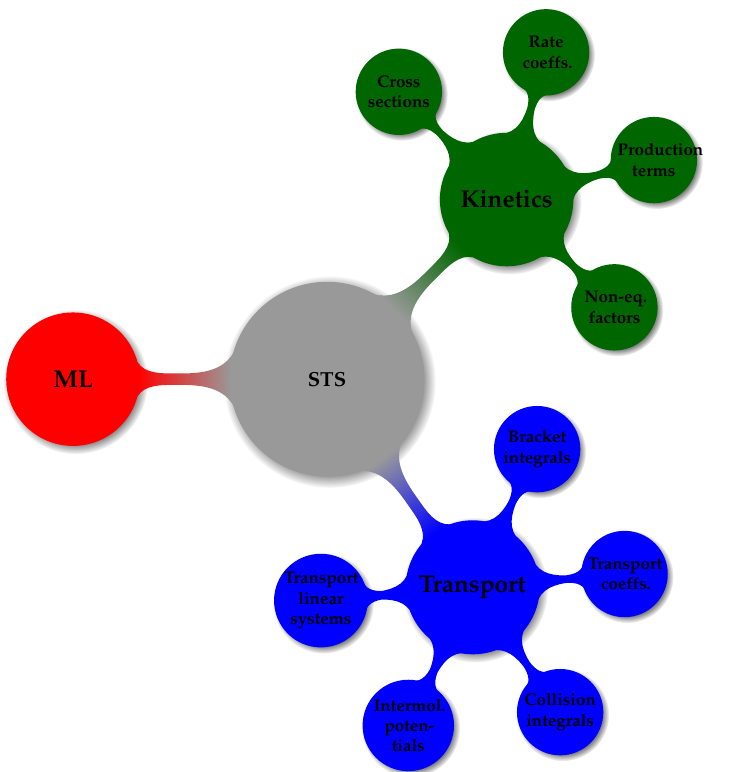
Figure 1. Machine learning for state-to-state: conceptual